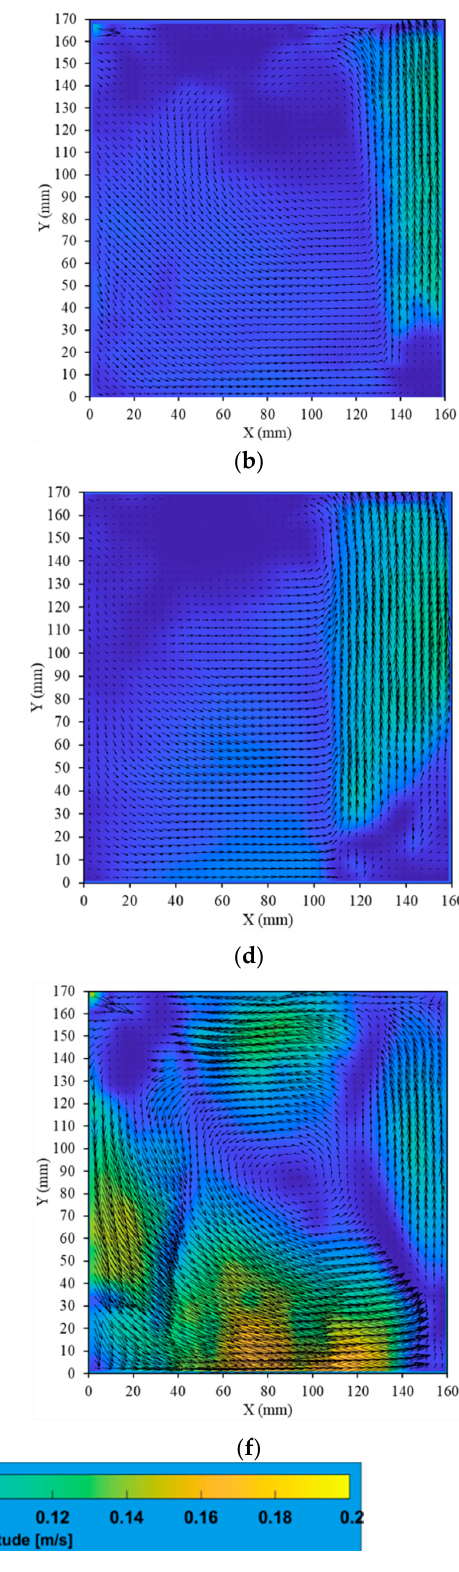
Figure 9. The velocity distribution of bubble flow fields under different aeration intensities: ( a ) aeration intensity = 0.07 L·L − 1 NS·min − 1 , ( b ) aeration intensity = 0.15 L·L − 1 NS·min − 1 , ( c ) aeration intensity = 0.29 L·L − 1 NS·min − 1 , ( d ) aeration intensity = 0.59 L·L − 1 NS·min − 1 , ( e ) aeration intensity = 1.18 L·L − 1 NS·min − 1 , and ( f ) aeration intensity = 2.35 L·L − 1 NS·min − 1 .